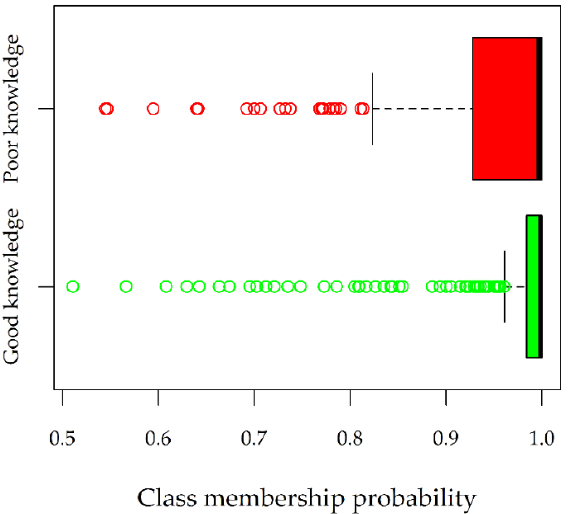
Figure 3. Assignment probability distribution by class. The boxplots represent median values (bold lines next to 1), 25th percentiles (box boundary lines), extreme values (whiskers), and outliers (points).